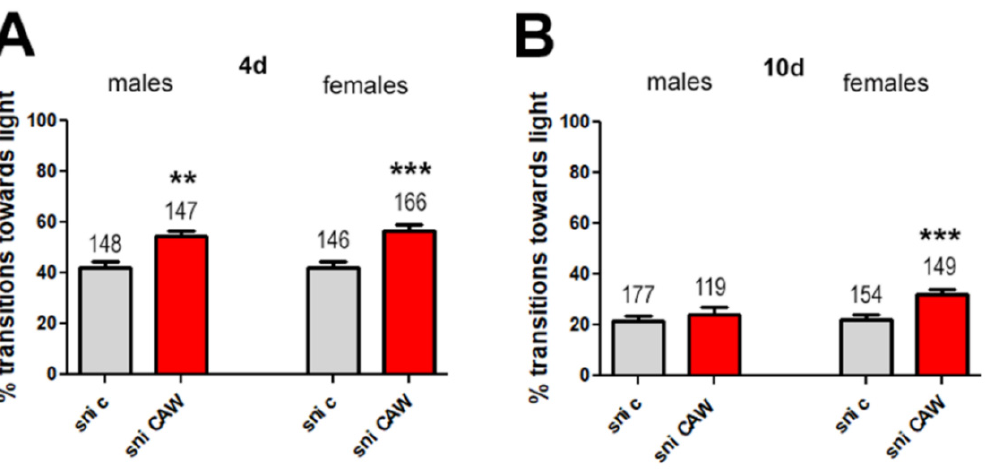
Figure 4. Percentage transitions towards light for Sniffer (sni) flies treated with CAW (10 mg/g) provided in yeast paste. Drosophila melanogaster sniffer mutants were fed yeast paste (c) or yeast paste supplemented with CAW (10 mg/g) for 4 days ( A ) or 10 days ( B ). Fast phototaxis was performed with flies in groups of 10–15 flies and separated by experimental group and sex. The number of flies tested is indicated above the bars. Error bars represent SEMs. ** = p < 0.01, *** = p < 0.001.